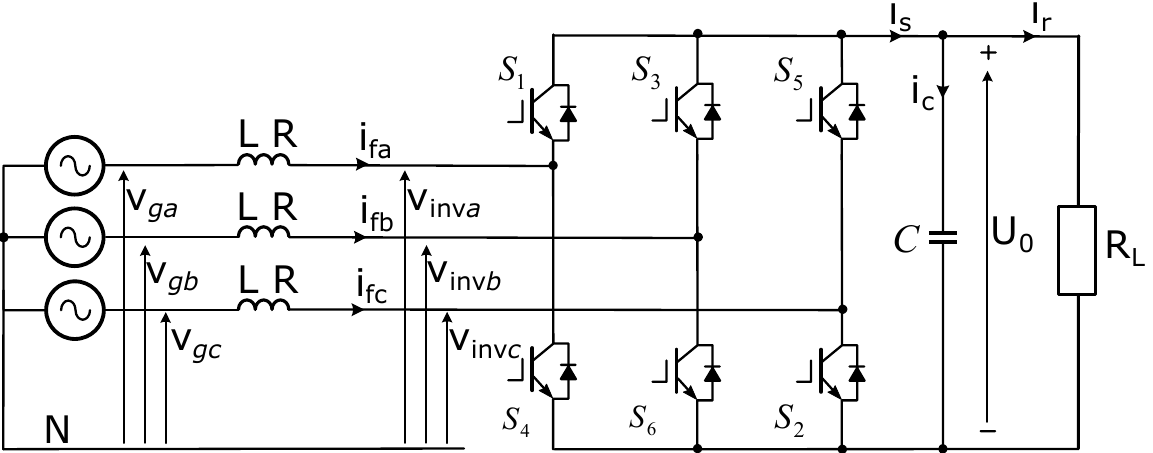
Figure 8. Grid-side Converter